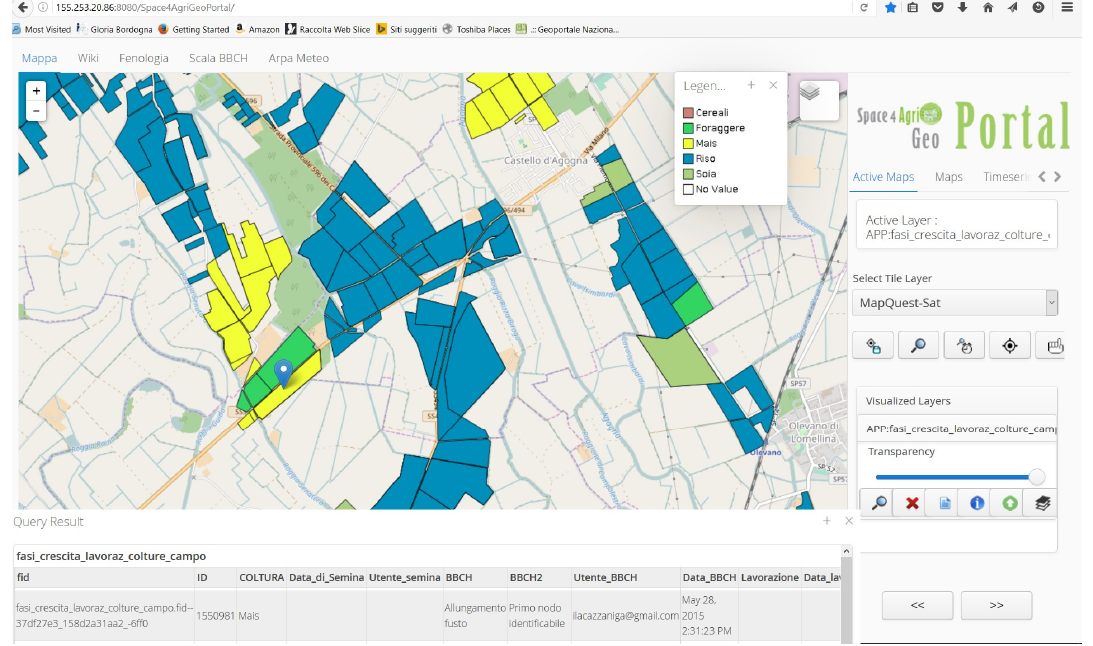
Figure 4. S4A geoportal displaying crop fields tagged with VGI; the distinct colors of the fields represent distinct crop types. The table displays all the VGI items corresponding to the observation of the BBCH growth stage in the cornfield marked with the blue pin.